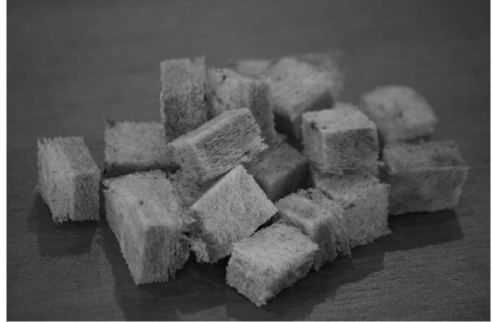
Figure 5. Floating carrier “Polyvom”. 4. Floating carrier BB 1200 (bioballs) manufactured by Tetratec (hereinafter “BB”, Figure 6); appearance: Spheres with a diameter of 12 mm, made of polypropylene, with a developed inner surface. Volume weight 50 kg/m 3 , specific surface area 620 m 2 /m 3 .